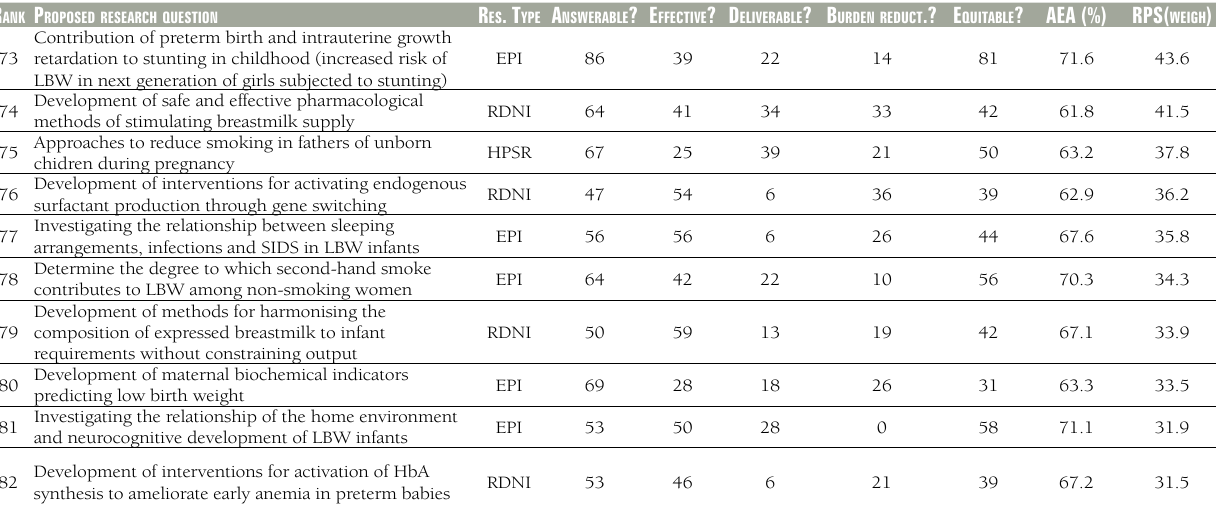
Table 4 The bottom 10 research questions according to their overall research priority score (RPS), with average expert agreement (AEA) related to each